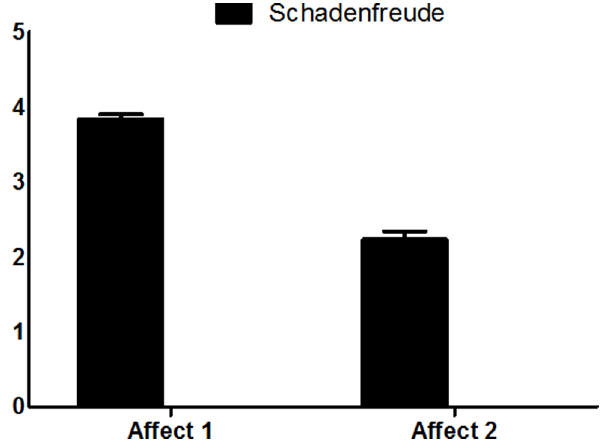
Figure 4. Affect scale. A significant change in negative affect (reduced positive affect) in the jealousy condition.